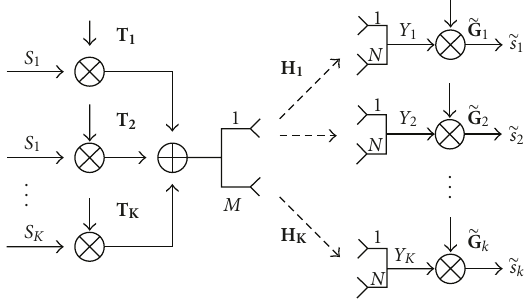
Figure 2: The block diagram of MU-MIMO system